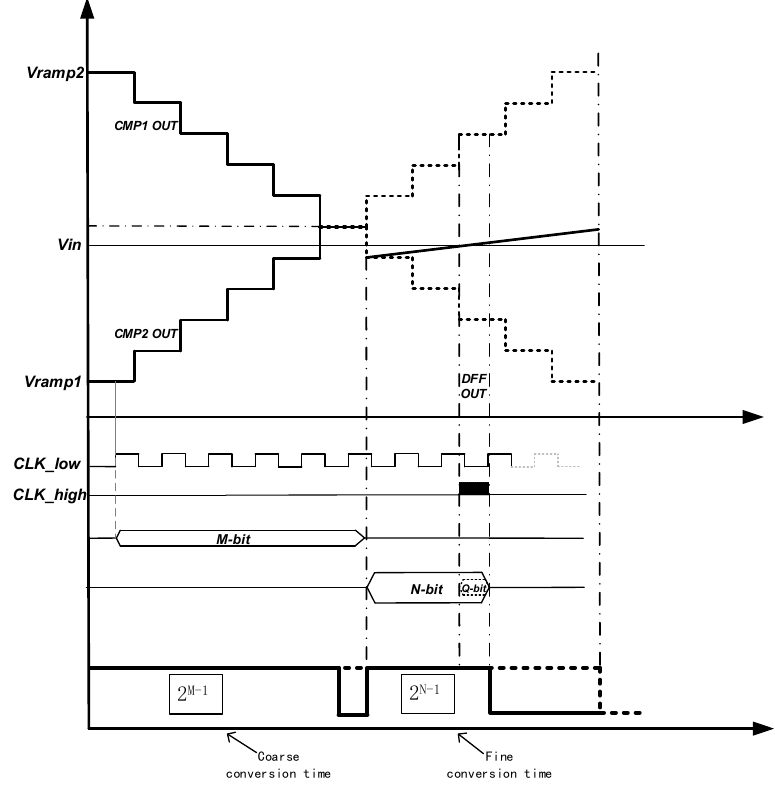
Figure 8. Timing diagram of the proposed circuit.